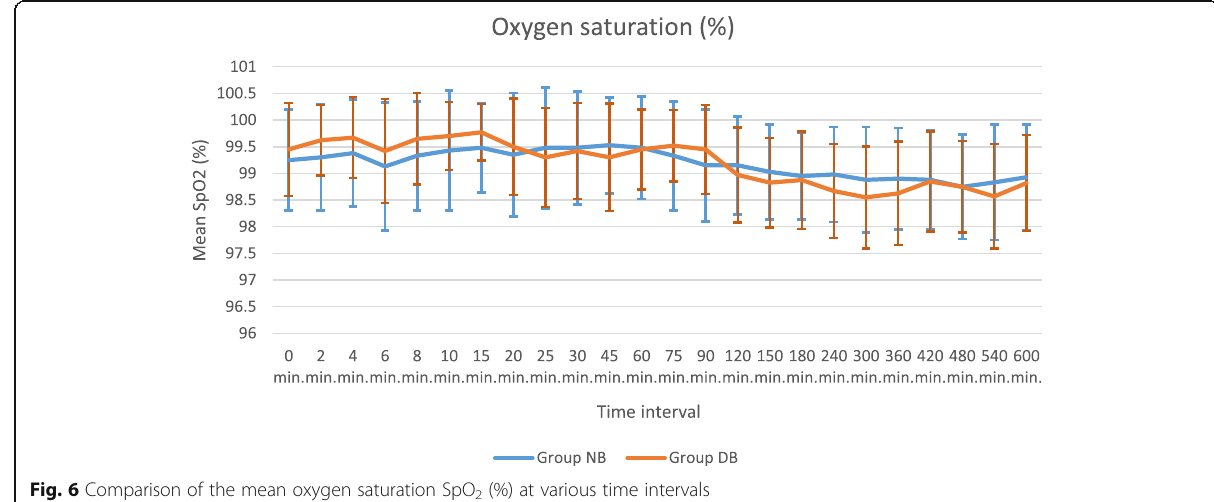
Fig. 6 Comparison of the mean oxygen saturation SpO 2 (%) at various time